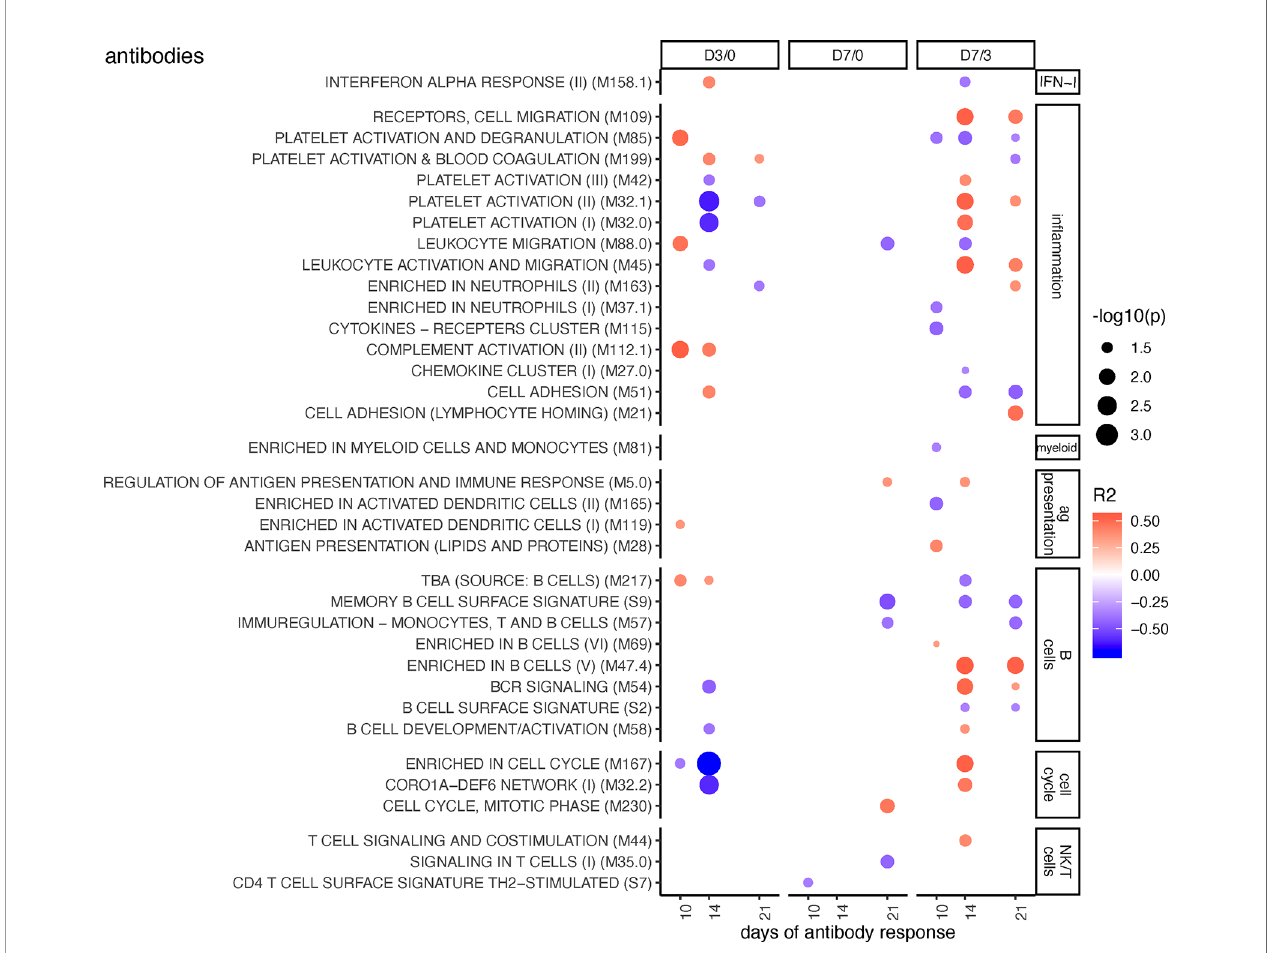
FIGURE 2 | BTM correlating with anti-PRRSV inhibitory antibody levels. Time-dependent single sample enrichment scores for BTM were correlated with the AUC (0 – 21 dpi) of anti-PRRSV inhibitory antibodies [data from (16)]. R squared correlation coef fi cients for the BTM changes from D3/0, D7/0, and D7/3 are indicated by the color gradient (red for positive values, blue for negative values). Increased circle sizes indicate smaller p values (cutoff < 0.05). BTMs were grouped in families